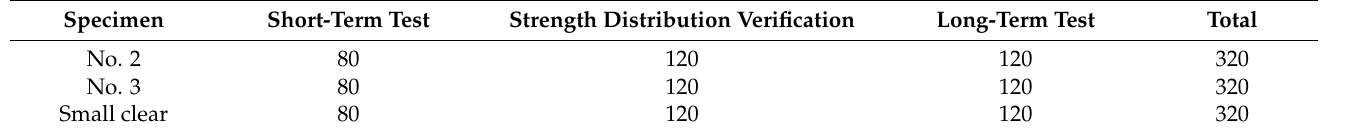
Table 1. The test